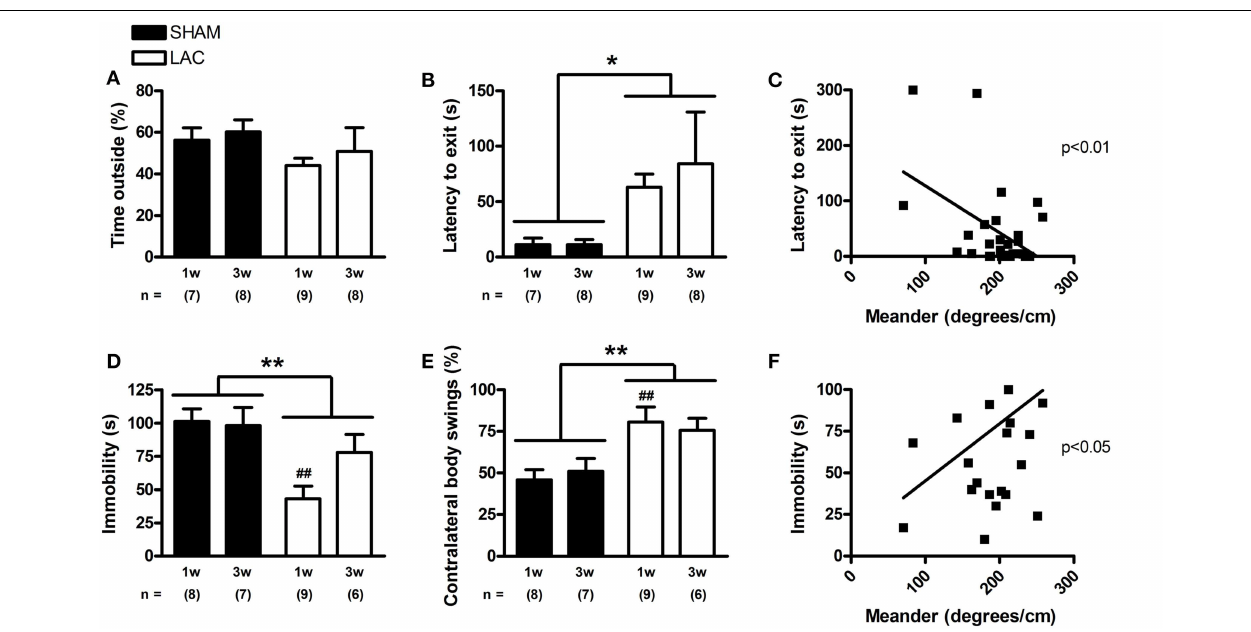
revealed that perseverative behavior (meander) correlates with latency to exit the shelter (C) , as well as with the immobility time in the tail suspension tests (F) . Mice treated with LAC also demonstrated significantly increased ipsilateral body swings compared to sham mice during their escape-oriented behavior (E) . Data are presented as mean ± s.e.m. * p < 0 . 05 , ** p < 0 . 01 (Two-Way ANOVA), ## p < 0 . 01 (Bonferroni post-hoc vs. sham). Sample size indicated in the figure. LAC